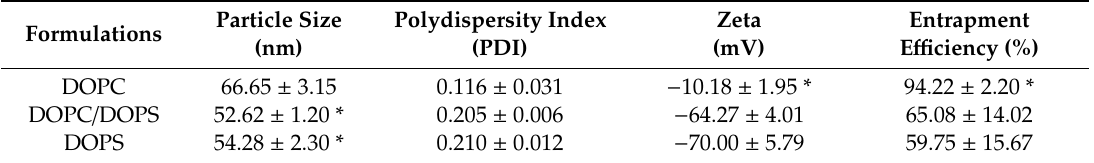
Table 1. Characterization of belinostat-loaded liposomes with DOPC, DOPS, and mixed PC/PS formulations in terms of particle size, polydispersity index (PDI), zeta potential, and entrapment efficiency.